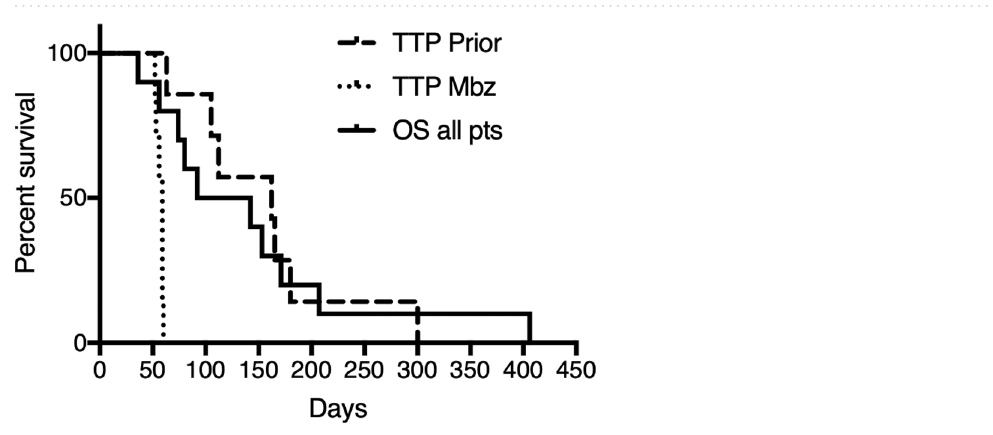
Figure 4. Time to tumour progression (TTP, days) while on the treatment preceding mebendazole (Mbz) and on treatment with Mbz for the patients (n = 8) included and evaluated by CT-scan at week 8. Overall survival (OS, days) are for all patients included and starting treatment phase (n =